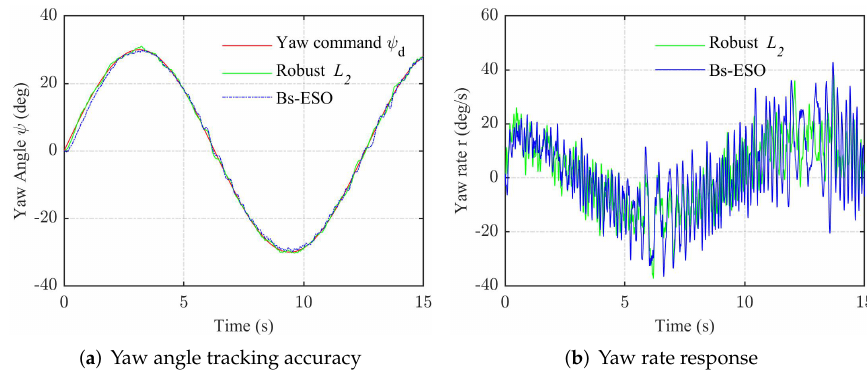
Figure 3. Noisy signal of injecting to attitude rate.